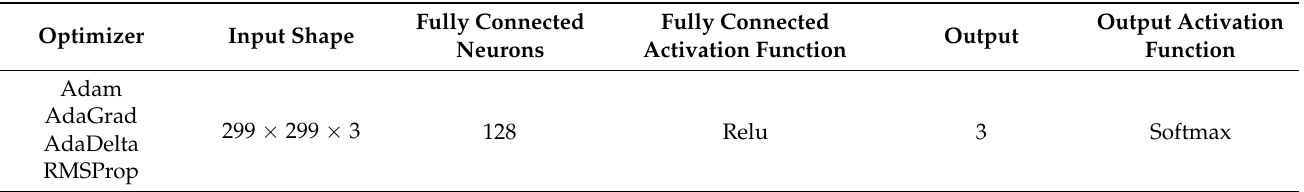
Table 2. Architecture of transfer learning model (InceptionResNetV2) with various